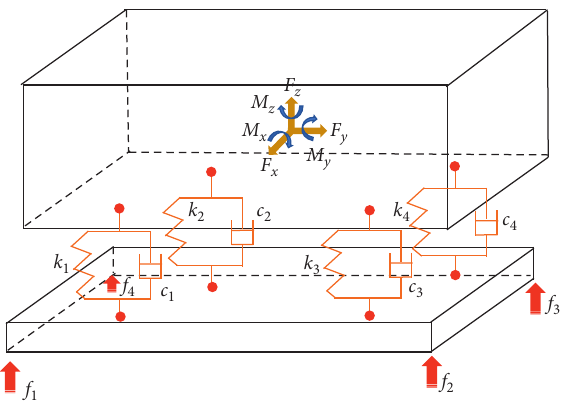
Figure 6: Dynamic response schematic diagram of the